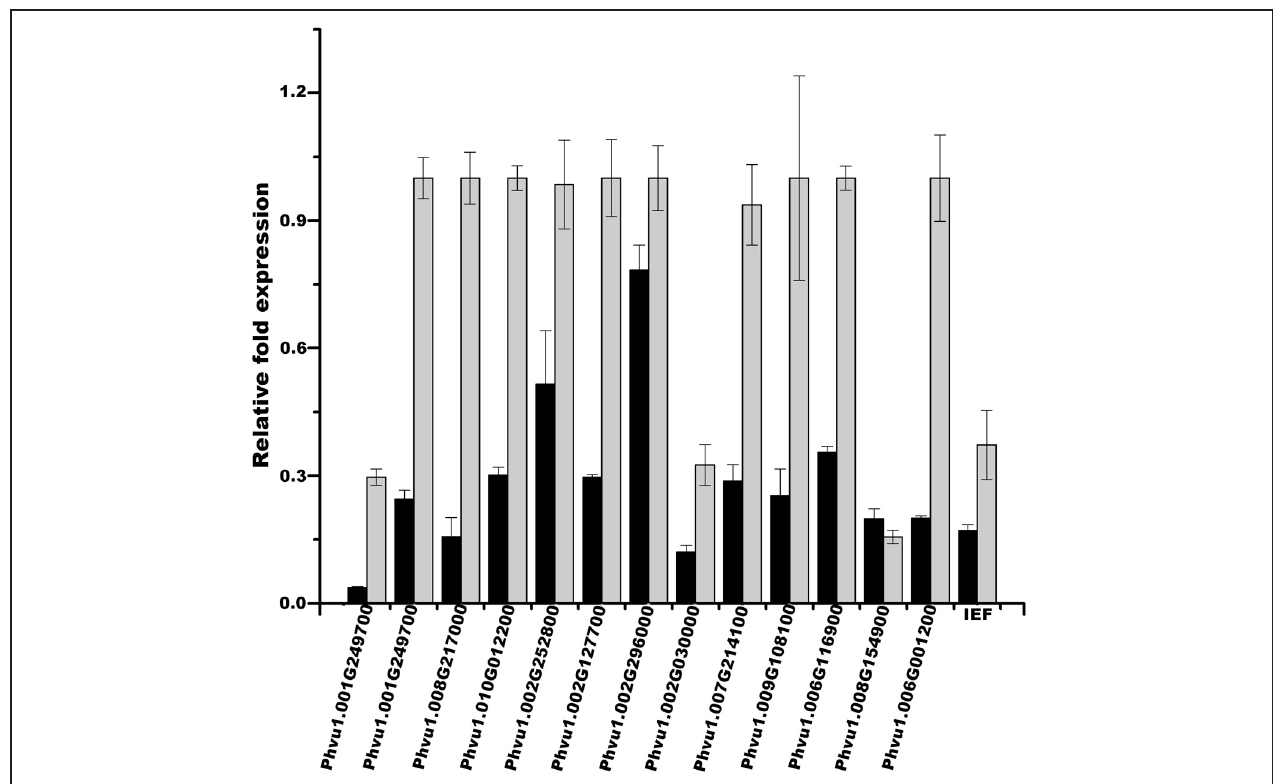
synthesized and subjected to qPCR as described in Materials and Methods. Expression levels were normalized against Elongation factor 1-alpha ( Ef1 - α ) values. Ratios of expression in nodule-stripped roots to nodules are graphed. These values represent the mean and SD of triplicate